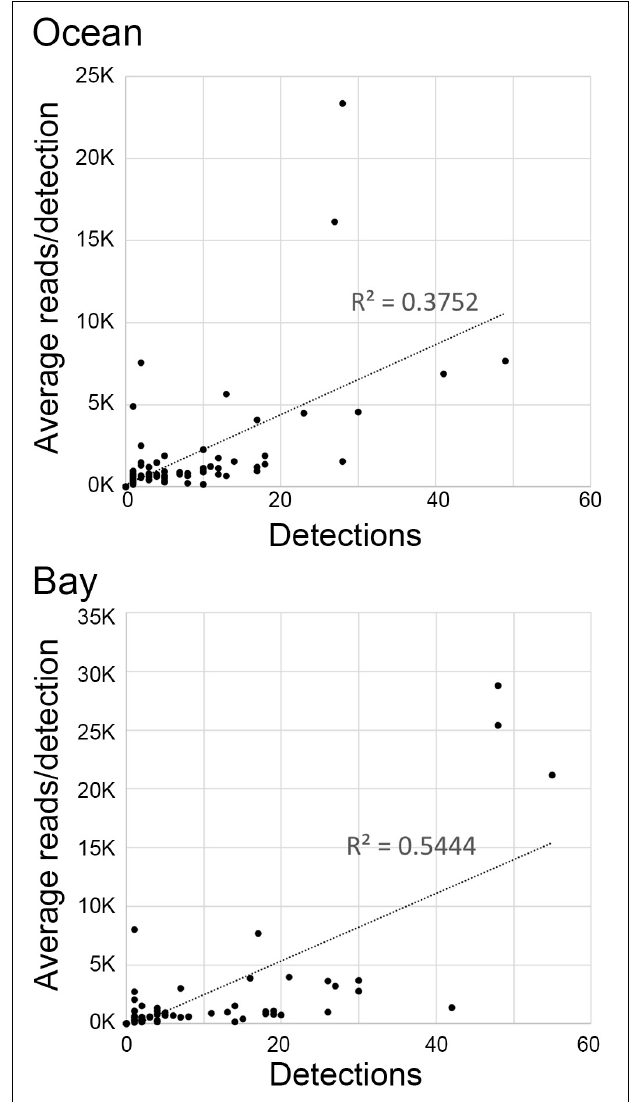
FIGURE 5 | eDNA abundance (average reads/detection) vs. frequency (number of detections) for bony fish